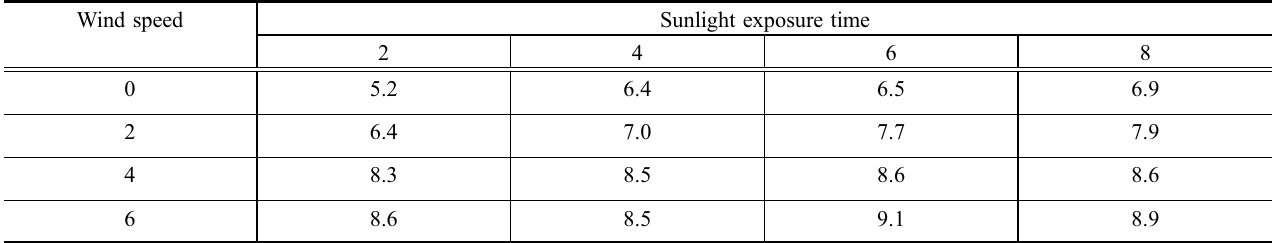
Table 6 Test results of concrete carbonation depth (unit: mm).